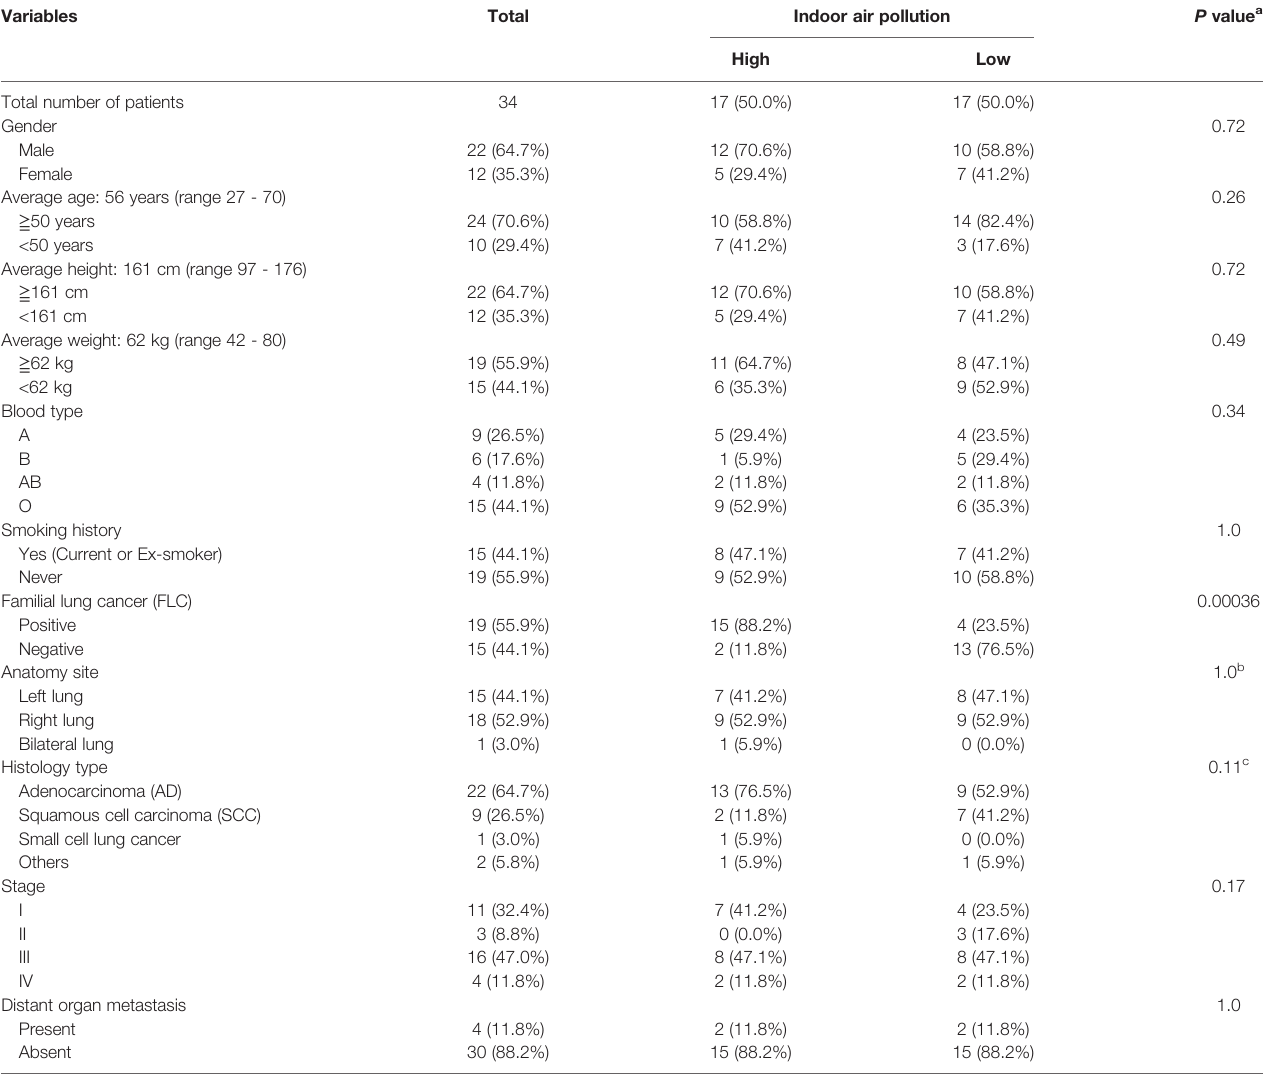
TABLE 2 | Clinicalpathological characteristics of 34 lung cancer patients divided by